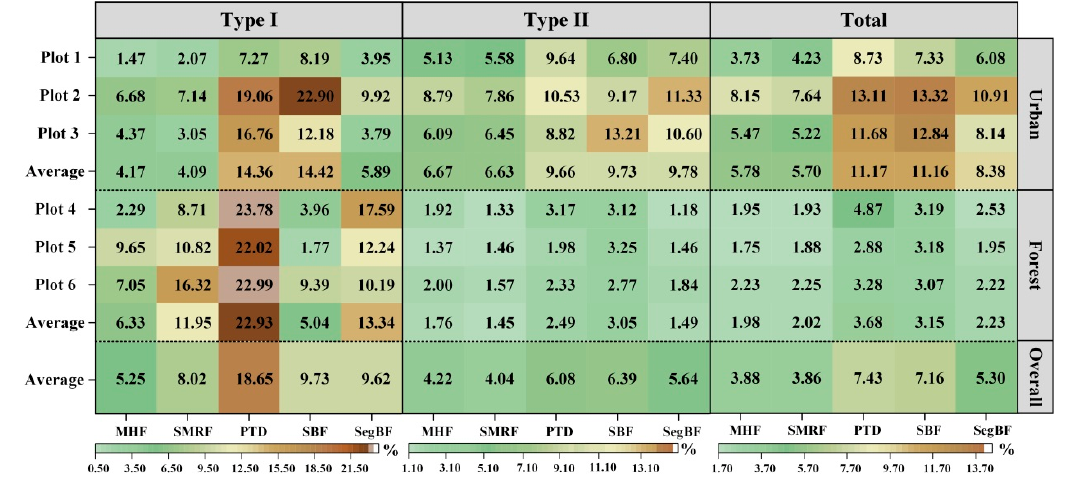
Figure 10. Type I, II and total errors of the filtering algorithms on the six plots.